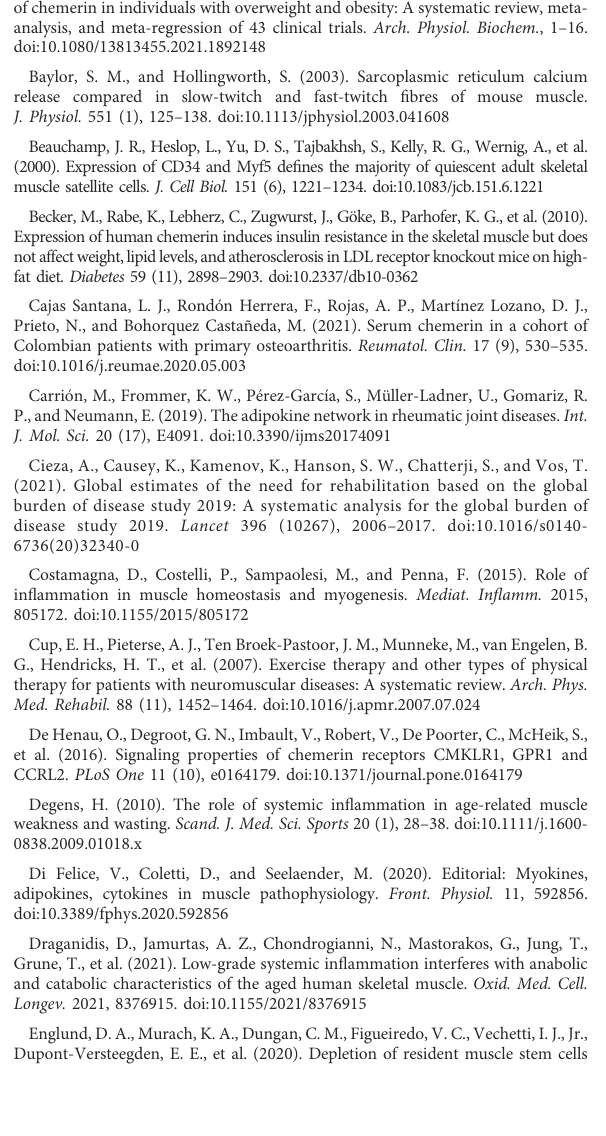
SUPPLEMENTARY TABLE S1 Body weight. SUPPLEMENTARY TABLE S2 Gait parameters